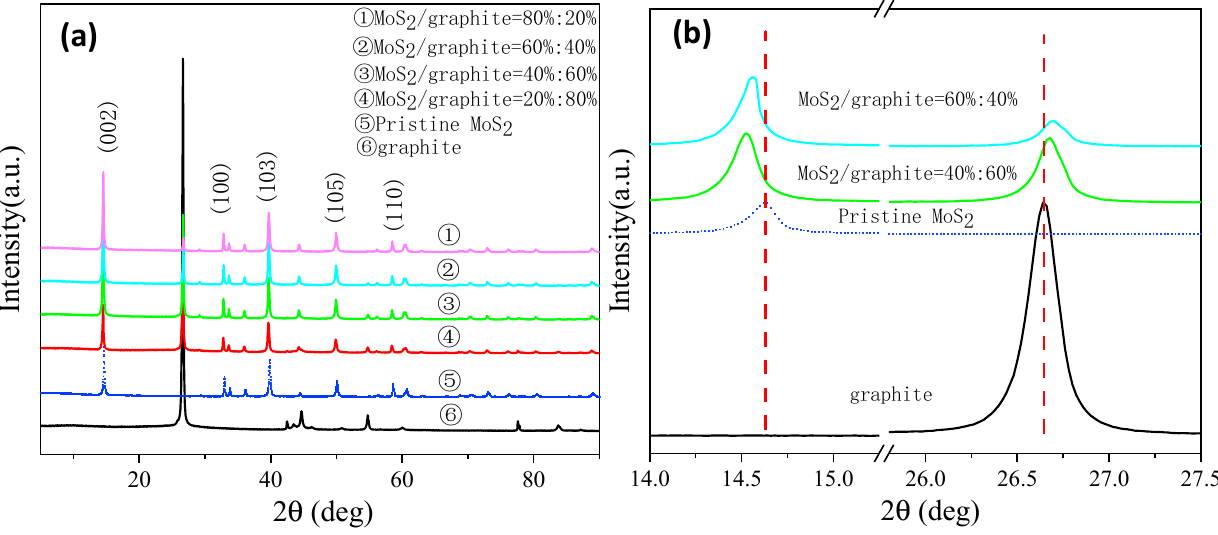
Figure 1. ( a ) XRD patterns of MoS 2 /graphite composites at different proportions; ( b ) Partial XRD